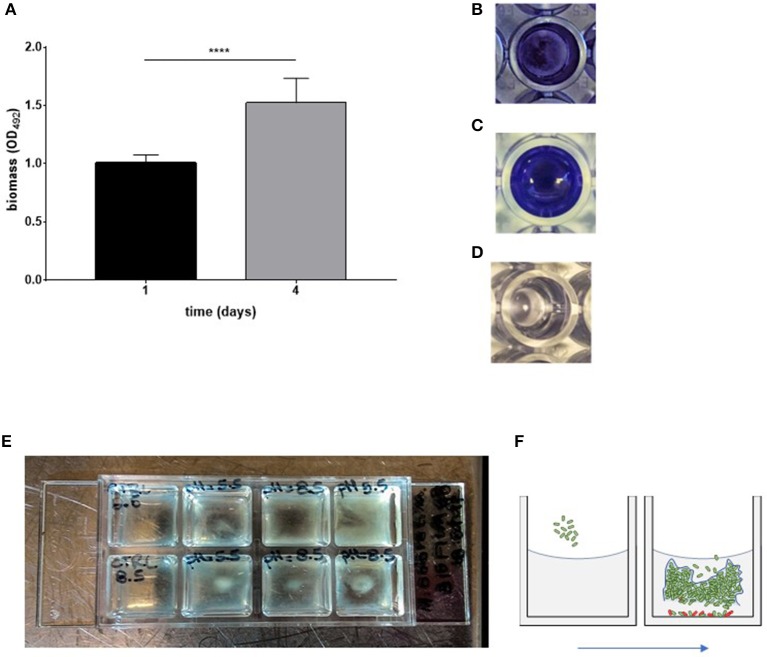
in vitro models to assess biofilm formation by Myroides odoratimimus. (A–D) Biofilm formation in 96-well polystyrene microtiter plate. (A) The biofilm biomass formed in TSB following 1 and 4 days of incubation at 37°C was assessed by crystal violet assay. Results are shown as mean optical density at 492 nm (OD492) + SD (n = 40). ****p < 0.0001, paired t-test, day 1 vs. day 4. (B) Biofilm sample formed in a well of a 96 well microtiter after crystal violet stain. (C) Biofilm sample following crystal violet extraction by glacial acetic acid. (D) Not inoculated (control) sample. (E,F) Biofilm formation in “skin-like” model (Werthén et al., 2010). (E) Biofilm was allowed to form in each well of a chambered coverslip μ-Slide 8-well, within three-dimensional matrix consisting of collagen type I and “simulated wound fluid” (SWF) to mimicry the serous exudate. Biofilm formation under different pH values (5.5 and 8.5) is indicated by the opacity observable within each well in the second, third and fourth column. Uninfected wells (control) are in the first column. (F) Schematic representation of biofilm formation within collagen gel matrix.